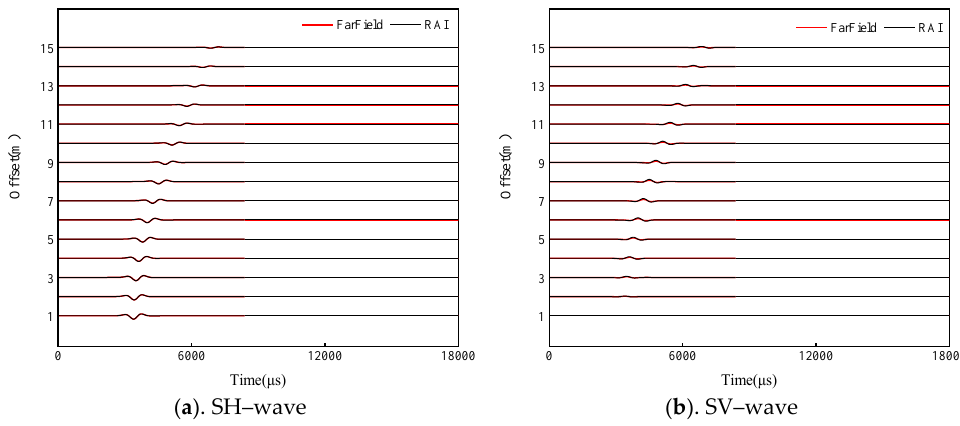
Figure 3. Far-field displacements of SH–wave and SV–wave obtained by the exact solution and the far-field asymptotic solution with the source frequency of 1 kHz in the medium formation.